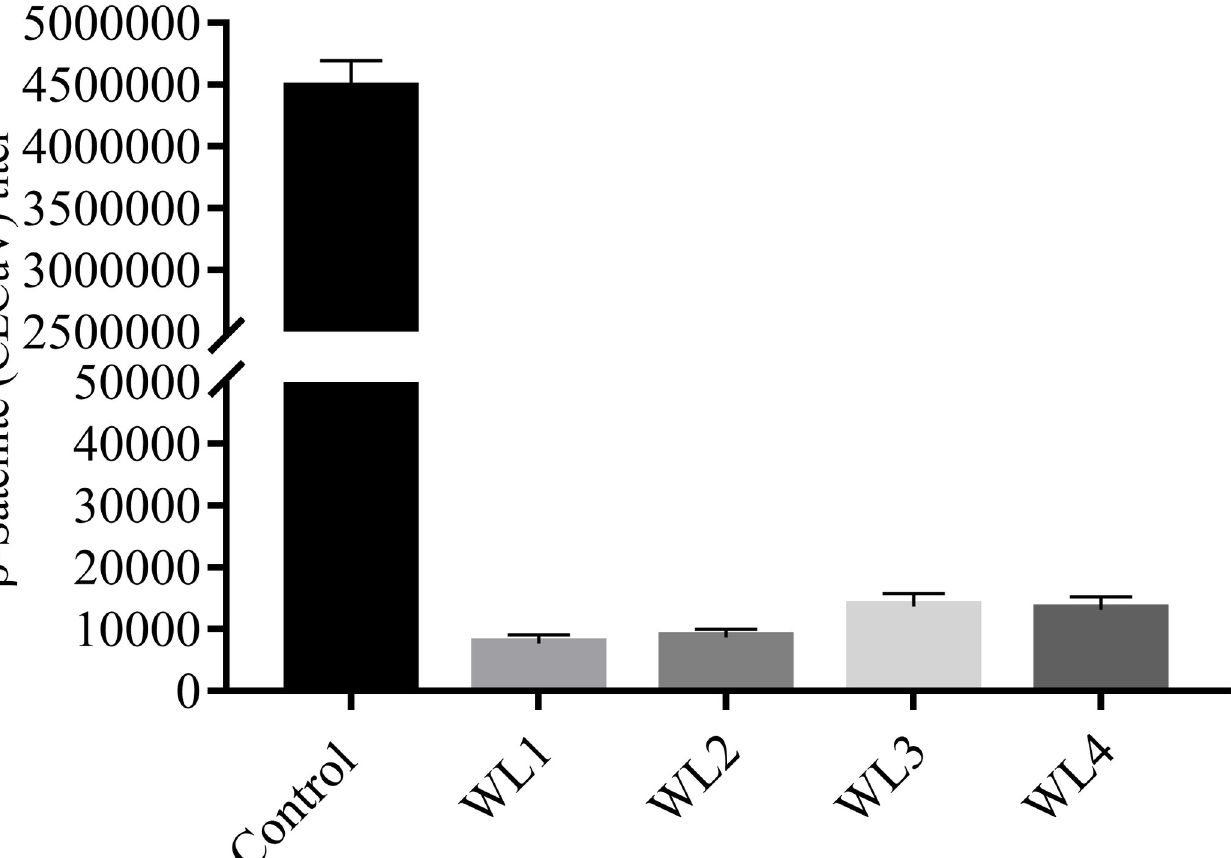
Fig 6. Measurement of CLCuV titer ( β -satellite) in control and transgenic cotton plants (WL1, WL2, WL3, WL4). https://doi.org/10.1371/journal.pone.0250902.g006 compounds composition has its role in determining the attraction of whiteflies for their visit to the plant. In one aspect reduction of wax quantity and change of composition in one of the mutant GaWM3 of G . arboreum a CLCuV resistant cotton variety resulted in an increased ten- dency of whitefly visits (Fig 7A). Feeding assay for both transgenic and control cotton plants was also done and the transgenic plants of G . hirsutum were observed to be less attractive for whitefly as compared to non-transgenic control cotton plants which further support the idea of wax role in changing the insect behavior for their visit to cotton plants (Fig 7B).